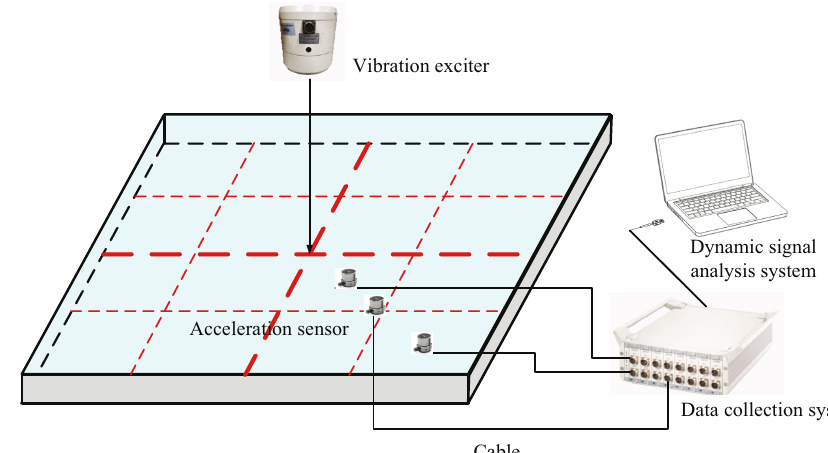
Figure 2: Schematic diagram of test.